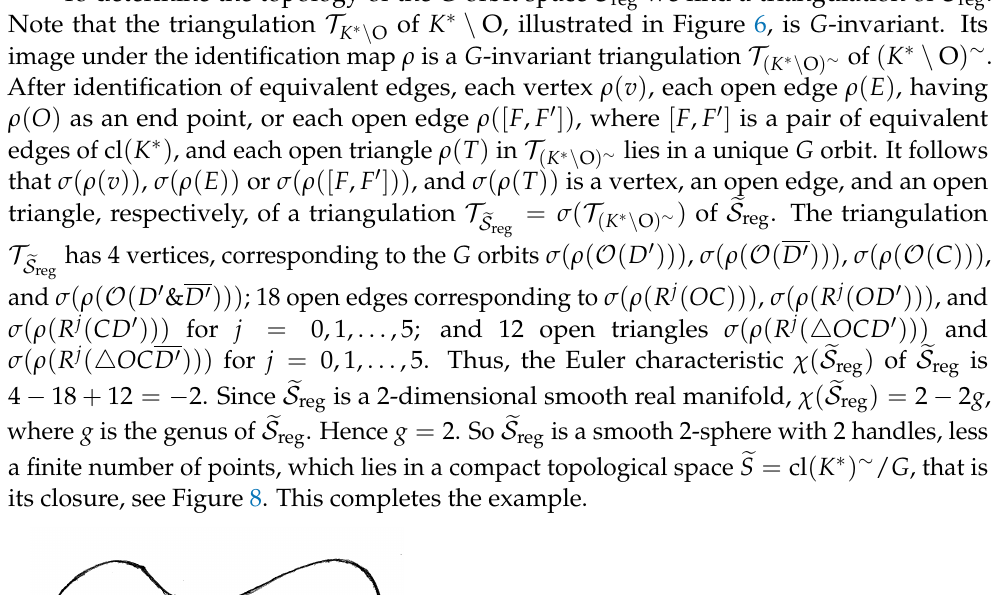
Figure 8. The G -orbit space